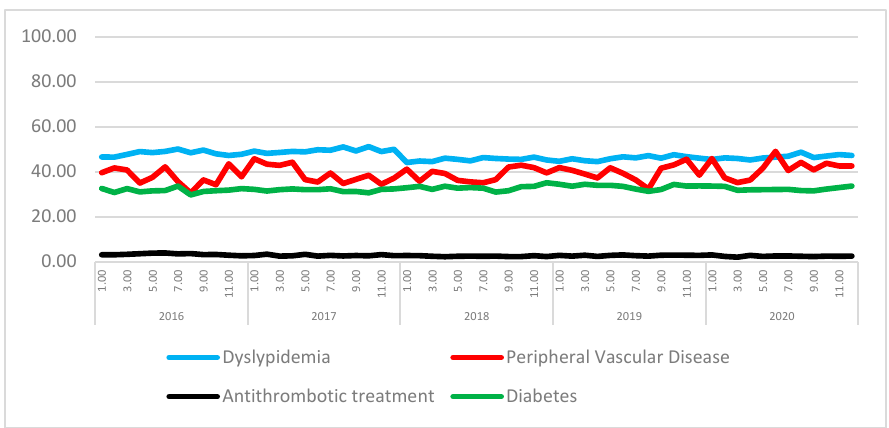
Figure 2. Time trends of relevant factors and treatments in patients with coronary revascularizations.